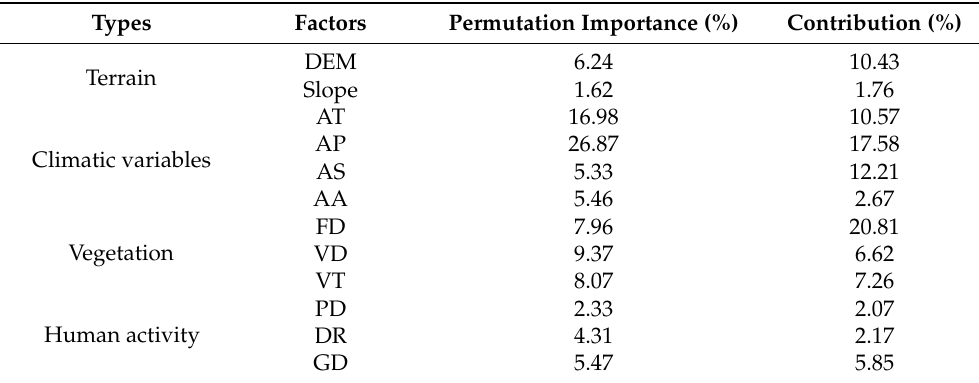
Table 2. Contribution and importance of major environmental variables to wildfire in Maxent